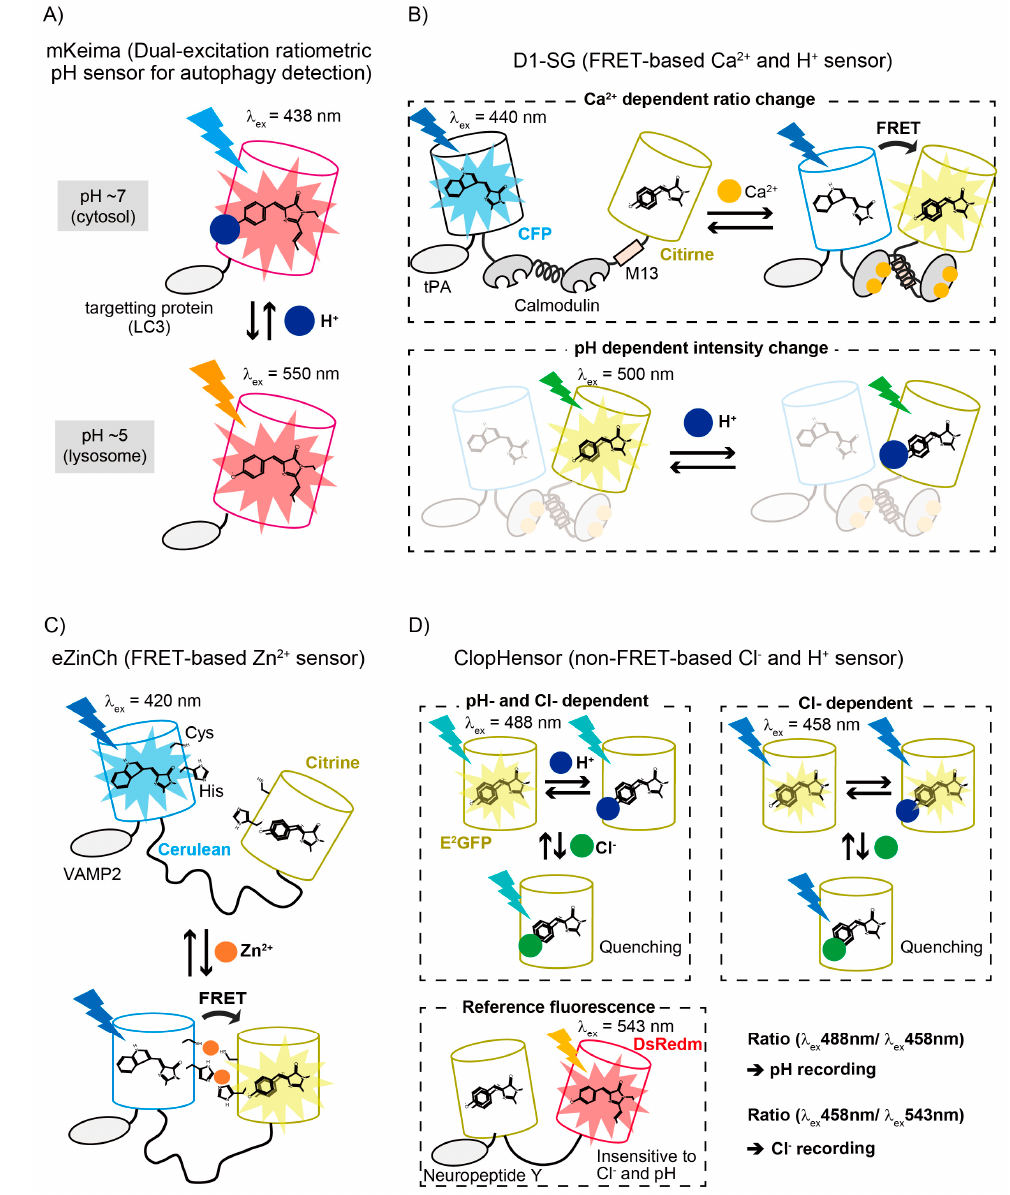
Figure 2. Schematic drawing of FP-based sensors for application in acidic organelles. ( A ) mKeima emits single emission at 620 nm, with dual excitation peaks at 438 and 550 nm, corresponding to protonated and deprotonated state of the chromophore. Under starvation-induced autophagy LC3-tagged mKeima is incorporated into autophagosomes, then recruited into lysosomes. This acidification induces color change of mKeima. LC3: microtubule-associated protein light chain 3; ( B ) D1-SG is a FRET-based and low-affinity Ca 2+ sensor applicable at pH levels between 5.5 and 7.4 ( K d ~120–190 µ M). Citrine can serve as an intentiometric pH sensor with direct excitation of ~500 nm, due to its inherent pH sensitivity (p K a = 5.8). tPA: tissue plasminogen activator (secretory granule localization); ( C ) eZinCh is FRET-based, with low-affinity Zn 2+ sensors composed of Cerulean and Citrine with Cys and His substitutions directed outside the β -barrel. Simultaneous use with pH sensor is necessary for pH calibration of the sensor. VAMP2: vesicle-associated membrane protein 2 (secretory granule localization); ( D ) ClopHensor records both Cl − and pH in a ratiometric manner by applying three lasers for excitation (458, 488 and 543 nm). E 2 GFP changes the ratio of two excitation peaks and fluorescence intensity (protonated and deprotonated forms) depending on Cl − concentration and pH. A pH isosbestic point exists at ~458 nm so that E 2 GFP emission under 458 nm excitation is